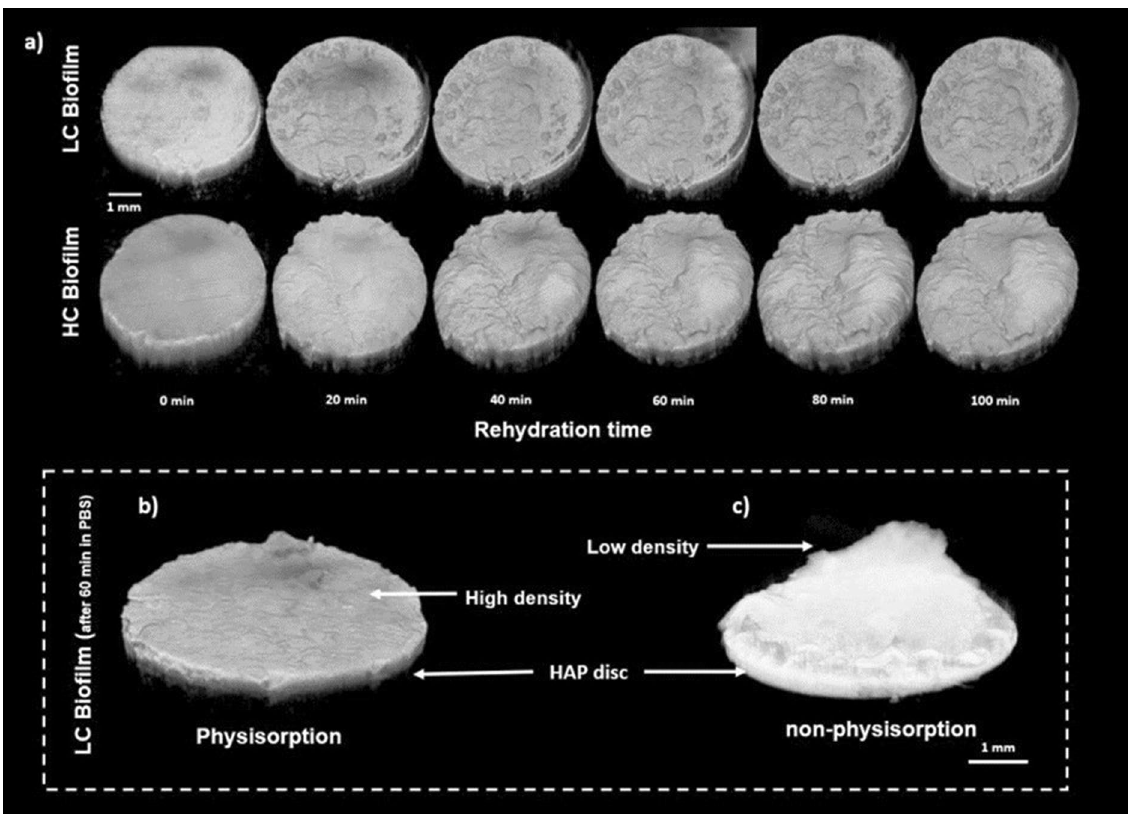
Figure 2. Showing ( a ) OCT images of both LC and HC biofilms at 20 min intervals up to 100 min, ( b ) showing effect of physisorption on LC biofilms after 1 h physisorption with ( c ) showing non-physiosorbed under PBS hydrated